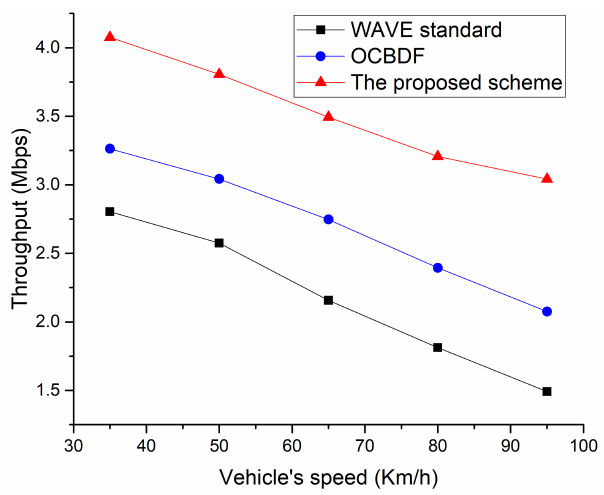
Figure 15. Throughput as a function of the vehicle’s